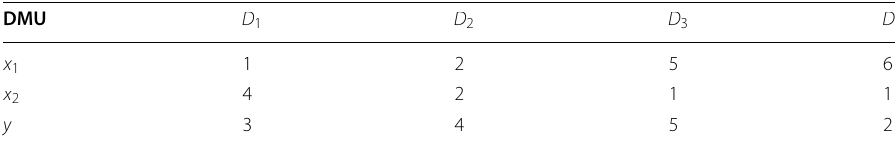
Table 1 Data of numerical example